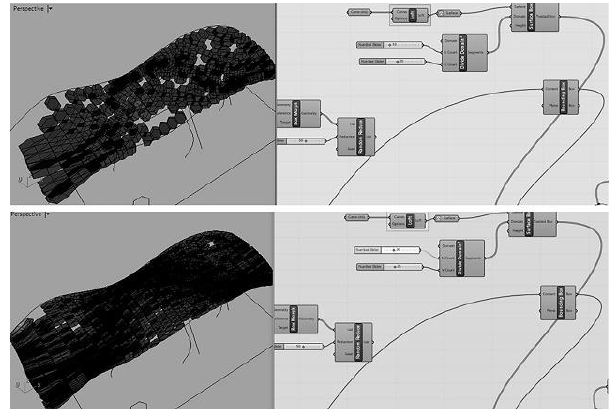
Figure 7. The Grasshopper models with various